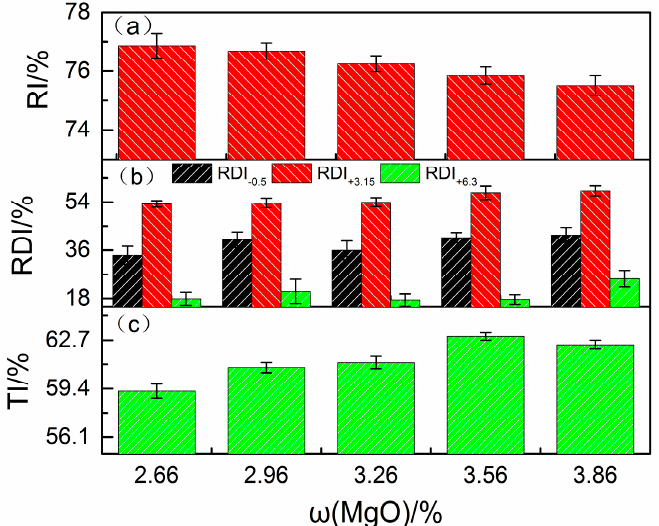
Figure 11. Metallurgical properties of the sinter with various MgO concentrations: ( a ) RI — reducibility index; ( b ) RDI — reduction disintegration index; ( c ) TI — tumble index.